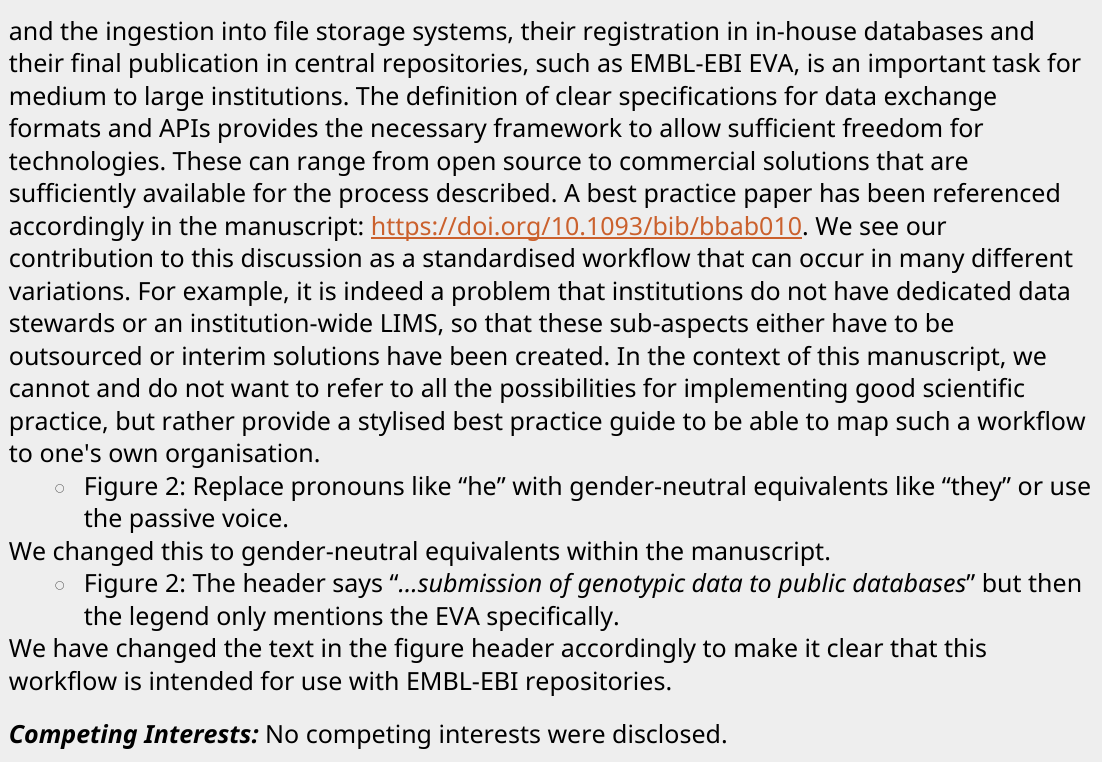
Figure 2: Replace pronouns like “he” with gender-neutral equivalents like “they” or use the passive voice. Figure 2: The header says “ …submission of genotypic data to public databases ” but then the legend only mentions the EVA